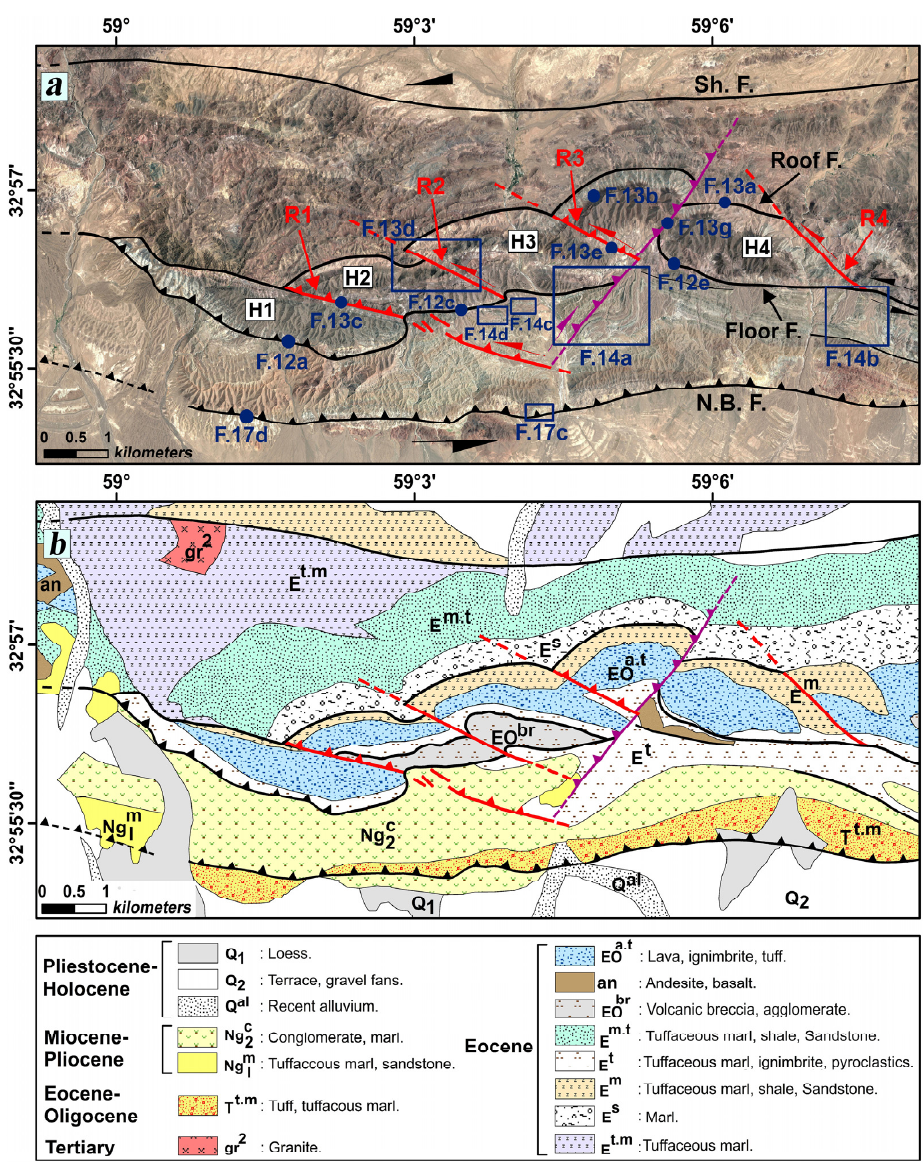
Figure 10. ( a ) Google Earth image and ( b ) geologic map of the Shekarab transpressional zone where the faults form a duplex structure between the two major North Birjand (N.B.F.) and Shekarab (Sh.F.) faults. H and R are the horses and ramps of the duplex, respectively. For details, refer to the